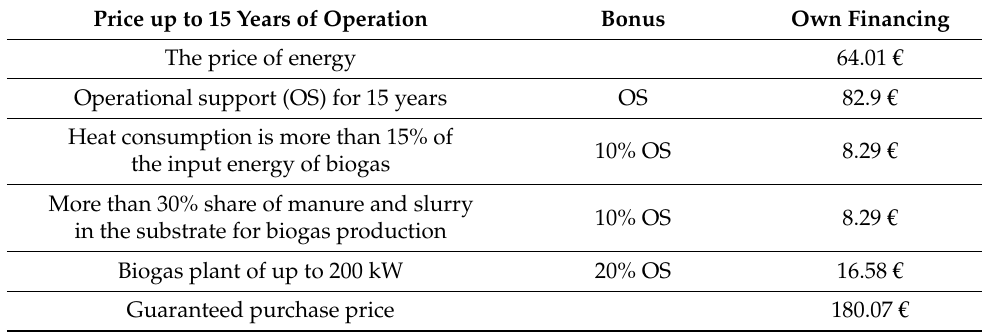
Table 2. Subsidies in EUR